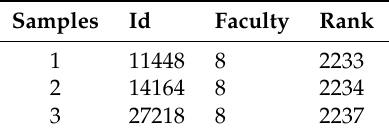
Table 6. Samples of the students achievement data.